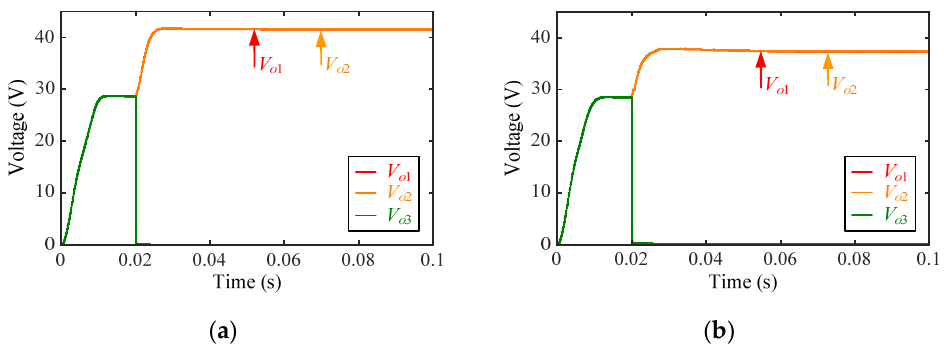
Figure 9. Output voltage waveforms under short-circuit conditions. ( a ) Without parameter optimi- zation. ( b ) With parameter optimization.